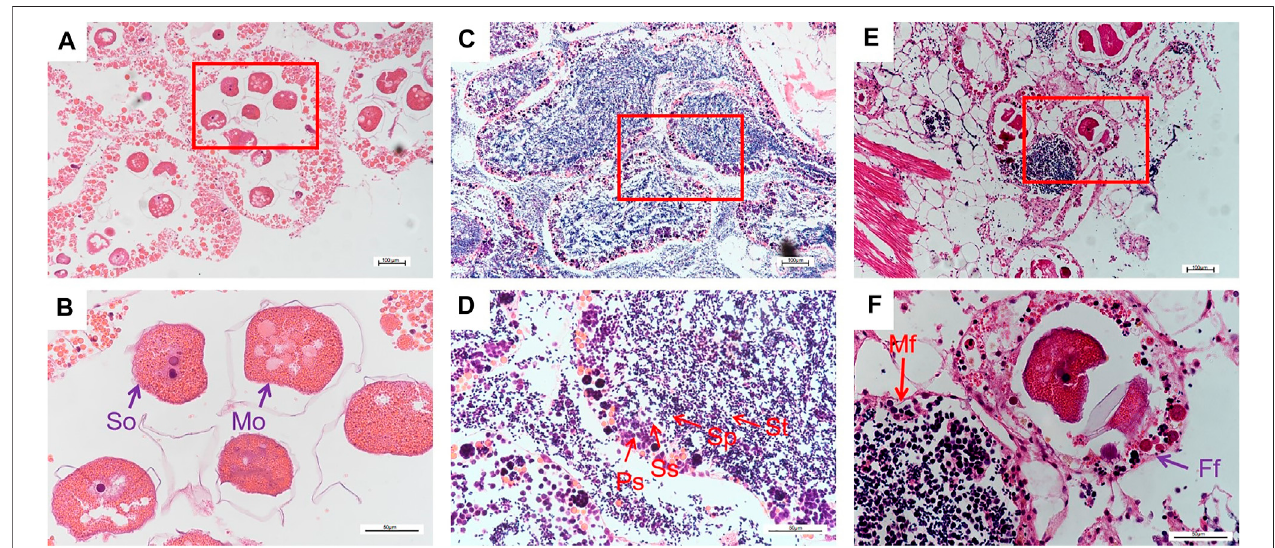
FIGURE1| Histologicalcharacteristicsofovary (A and B) ,testes (C and D) andhermaphrodite (E and F) from30-month-old H.schlegelii .;So:Secondaryoocyte; Mo: Mature oocyte; St: Spermatoblast; Sp: Sperm; Ss: Secondary spermatocyte; Ps: Primary Spermatocyte; M: Morula structure; Mf: Female follicle; Ff: Male follicle.